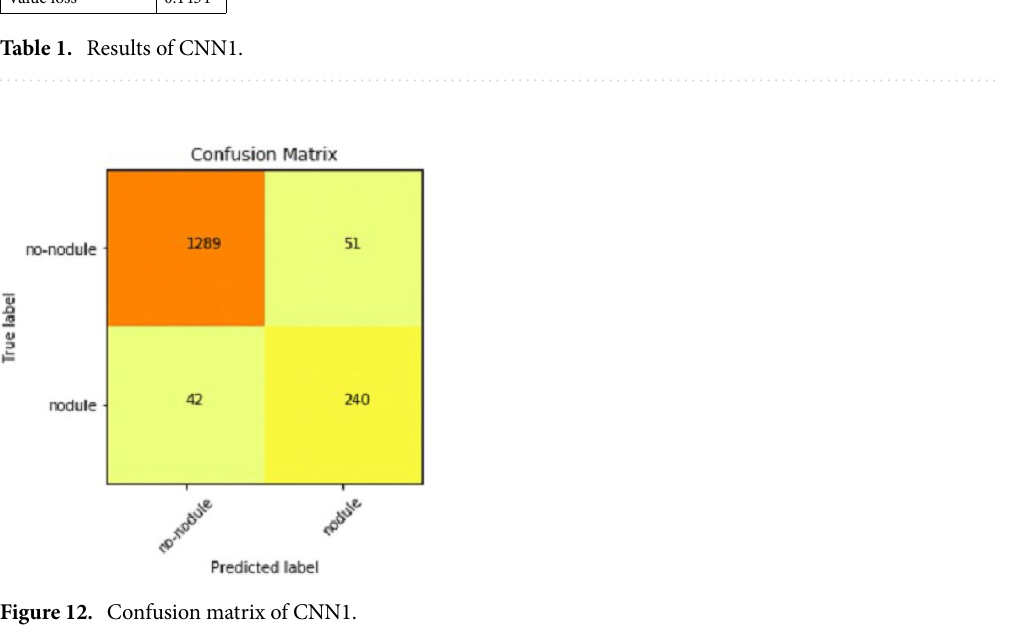
Figure 12. Confusion matrix of